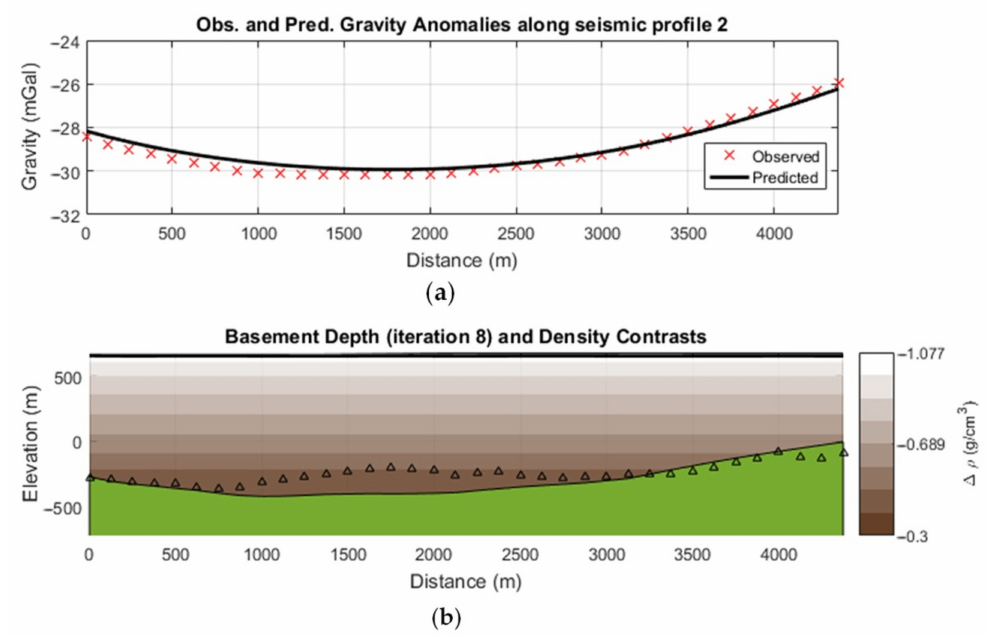
Figure 10. Comparison of the depth to the seismic reflector interpreted as the top of the carbonatic rocks, and the gravity basement along the seismic profile 2 (see Figure 2). ( a ) Observed and model- predicted gravity; ( b ) gravity basement (green) and seismic reflector (triangles). Brown shading represents the density contrast variation with depth estimated in the ITRESC modelling.